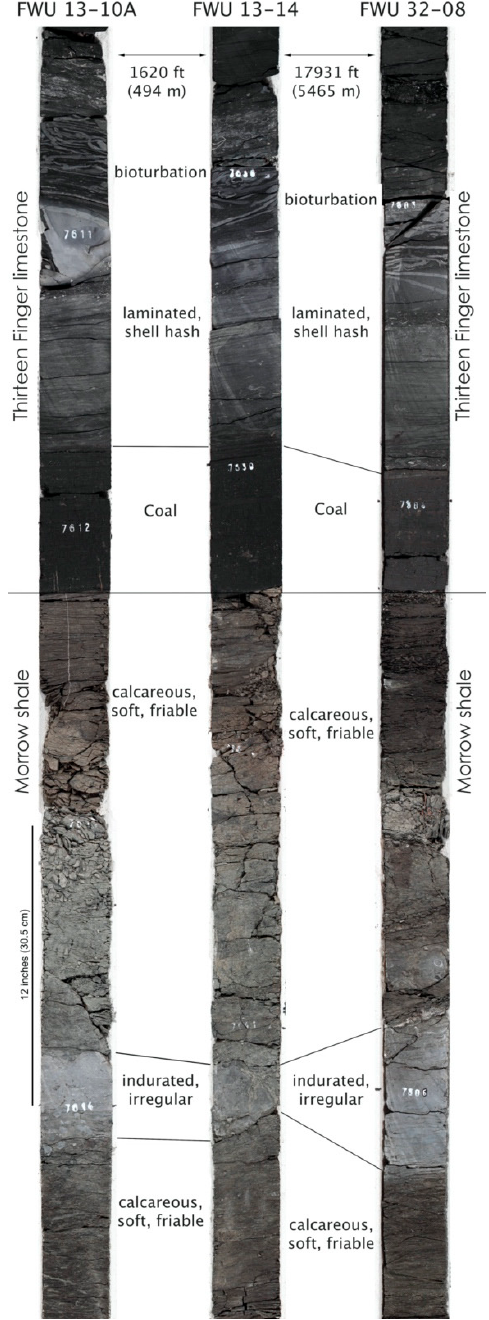
Figure 6. Uppermost sequence of Morrow shale that overlies the Morrow B, showing consistent sequence of lithofacies seen in all three characterization well cores. All core slabs are approximately 10-cm wide and 122-cm height. One-foot intervals marked on core.